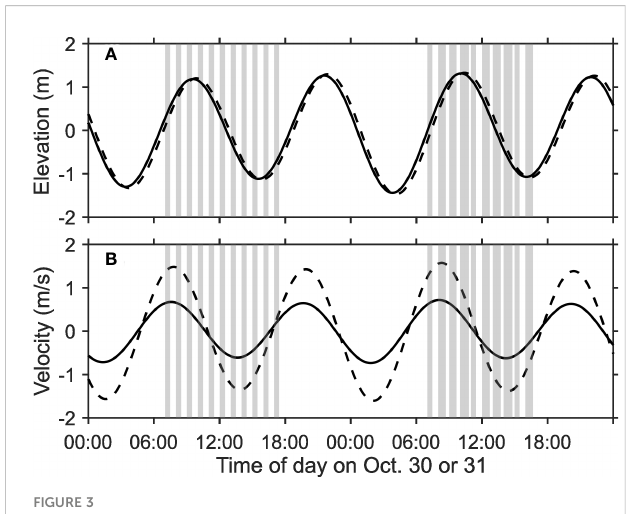
FIGURE 3 Time series of (A) tidal elevations and (B) tidal currents that were given as the open boundary conditions at the west (solid) and east (dashed) boundaries. The gray vertical bars indicate the time of the shipboard ADCP